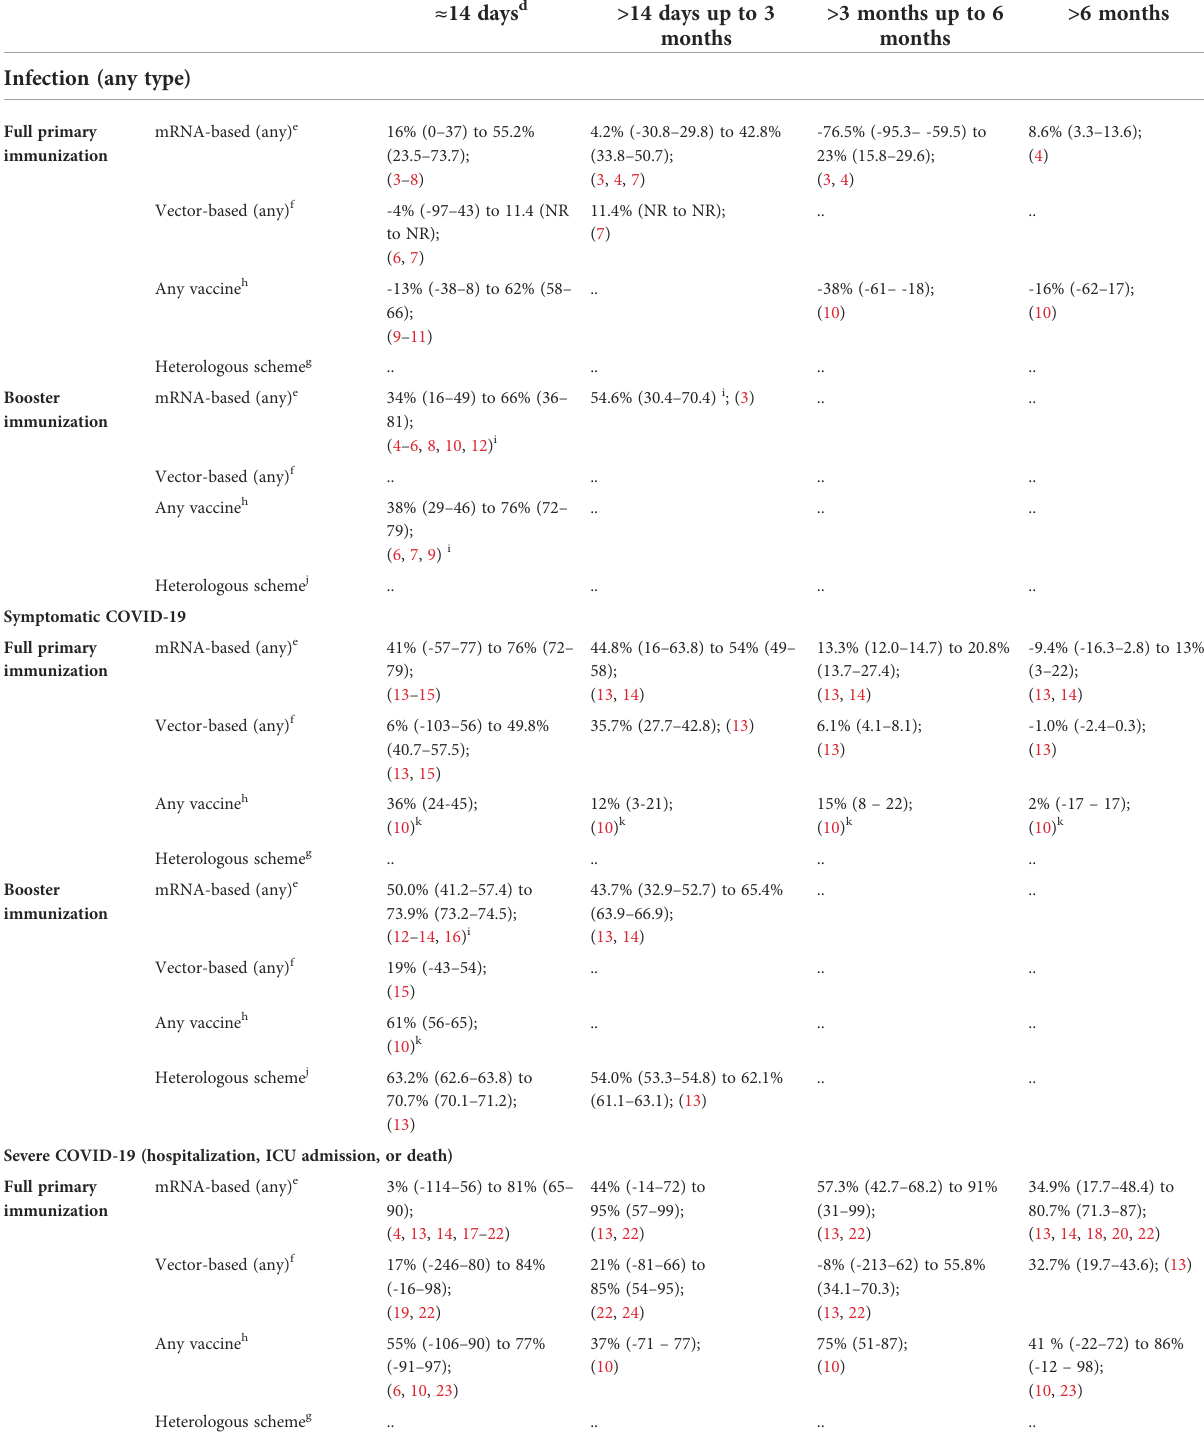
TABLE 1 Effectiveness of COVID-19 vaccines against SARS-CoV-2 Omicron variant infection (infection (any type), symptomatic COVID-19, and severe COVID-19 (hospitalization, ICU admission, or death)). Vaccine(s) used